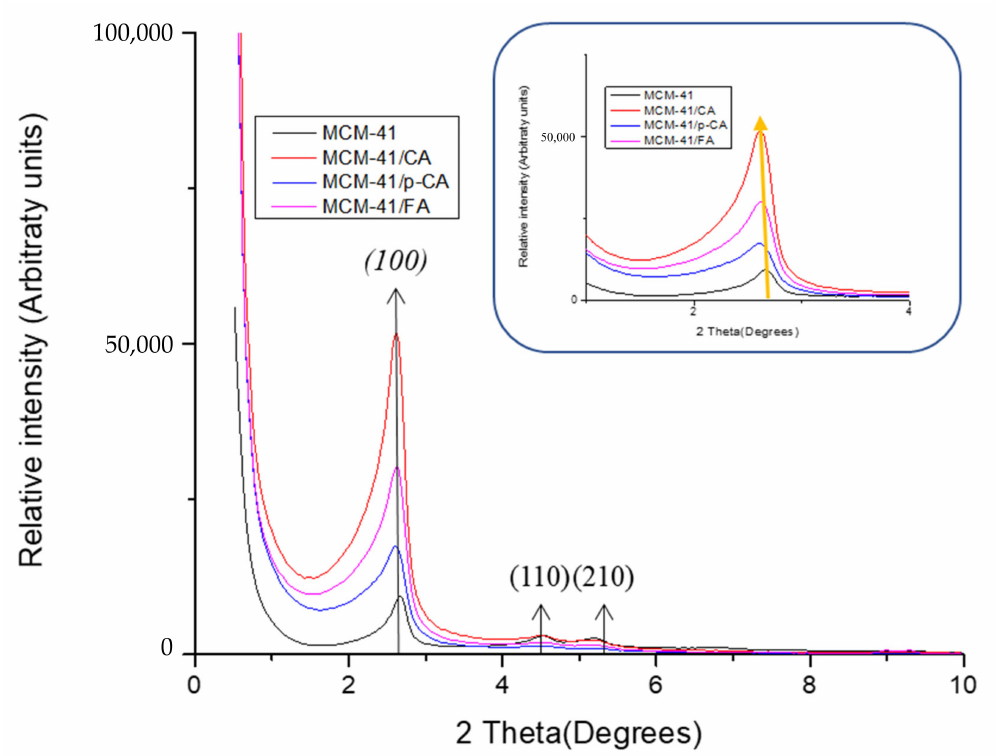
Figure 2. XRD diffractograms of samples MCM-41, MCM-41/CA, MCM-41/p-CA and MCM-41/FA.